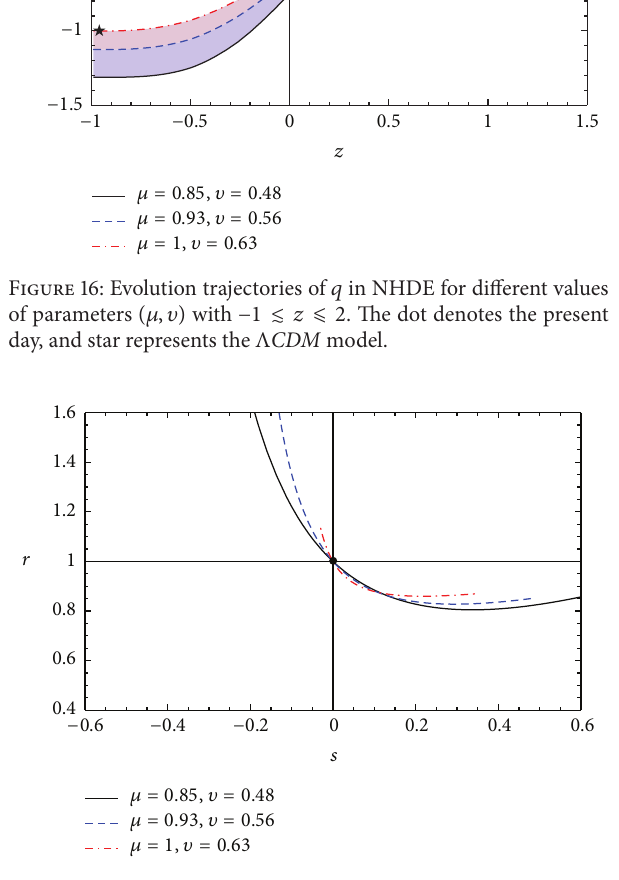
Figure 17: Evolution trajectories of statefinder diagnostic in NHDE for different values of parameters (𝜇,𝜐) with −1 ≲ 𝑧 ⩽ 2 .